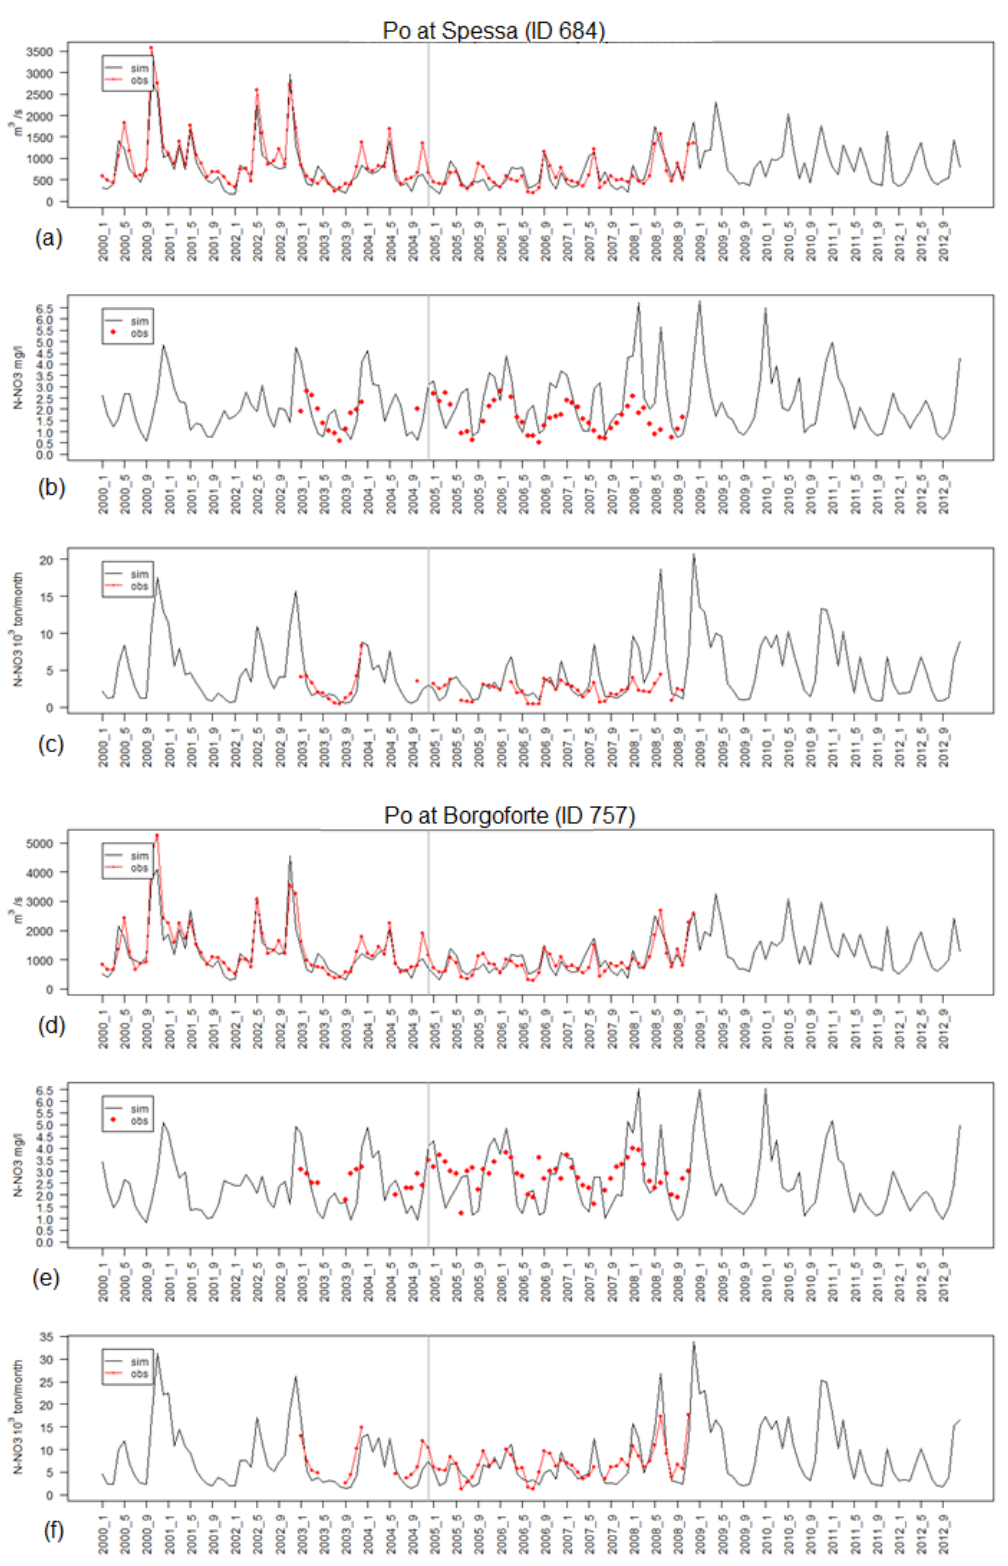
Figure 4. Monthly time series of streamflow ( a , d ), nitrogen-nitrate concentrations ( b , e ) and monthly loads ( c , f ) observed (red lines and points) and simulated by SWAT (black line) at two selected gauging stations across the Po River.